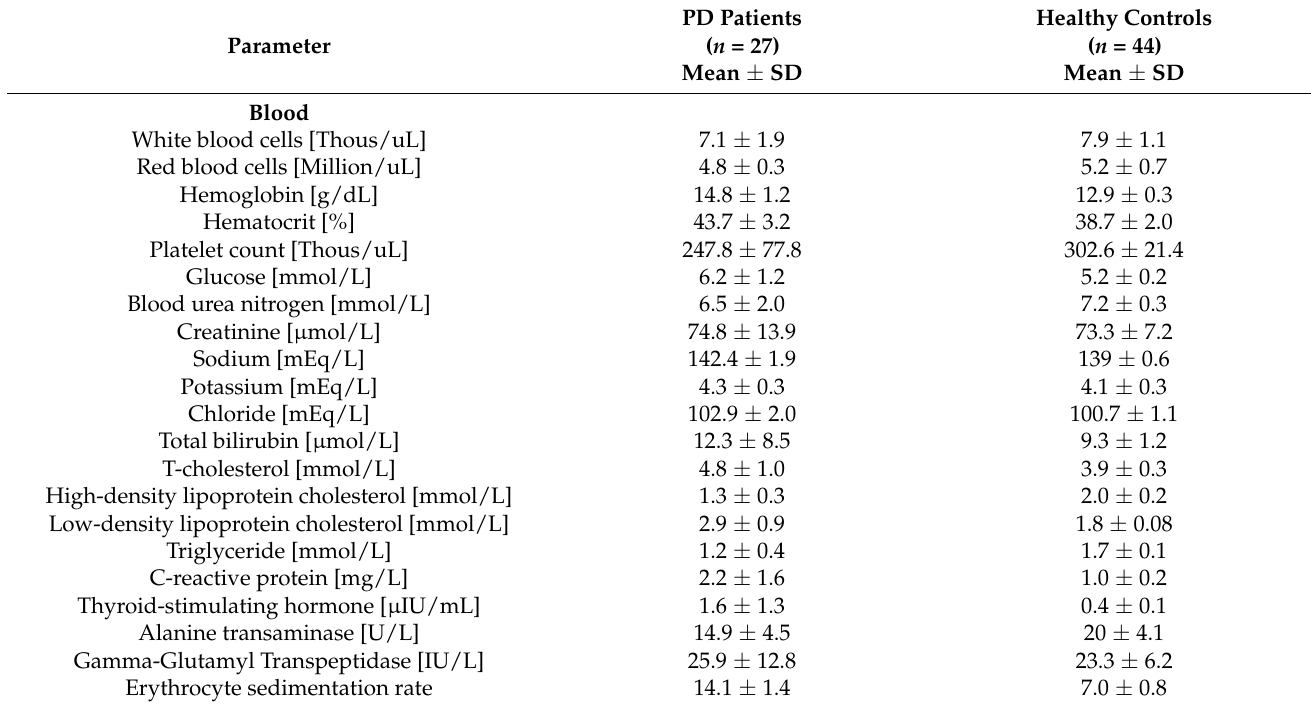
Table 2. Serum biochemical parameters and some other characteristics of urine samples of a patient with PD and healthy